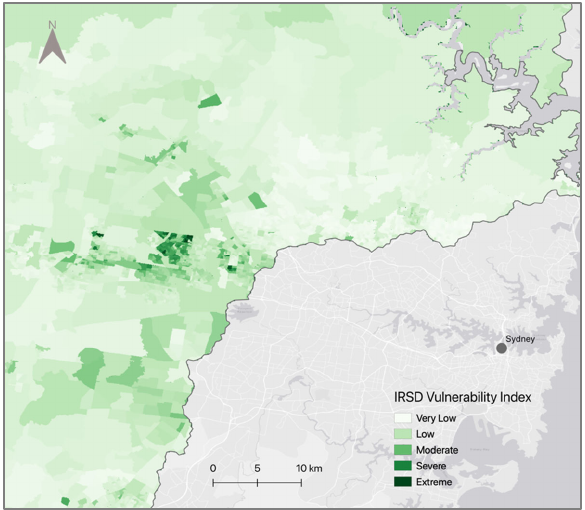
Figure 9. Magnified map depicting Index of Relative Socio-economic Disadvantage (IRSD) data across GWS after standardising with Fuzzy membership. Including a map of the area of concern.